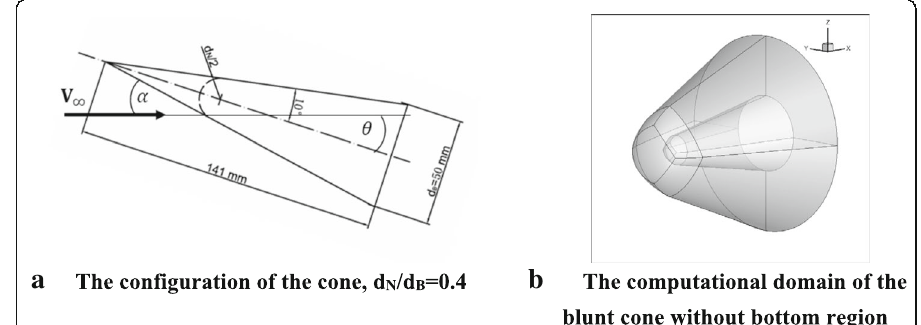
Fig. 2 The geometry and the computational domain of the blunt cone. a The configuration of the cone, d N /d B = 0.4. b The computational domain of the blunt cone without bottom